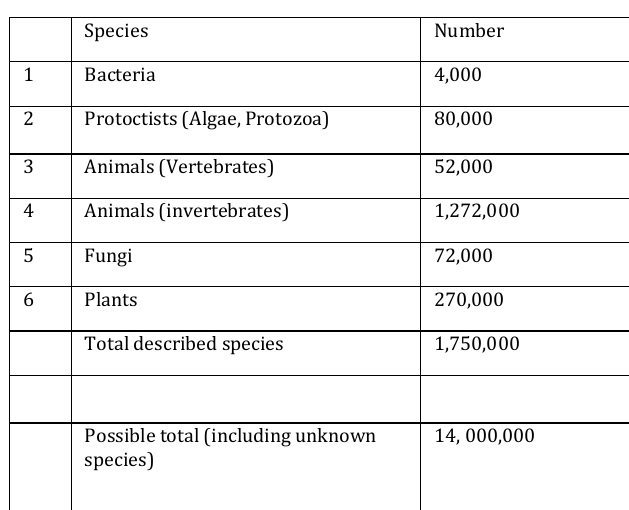
Table 1: Number of Described Species on